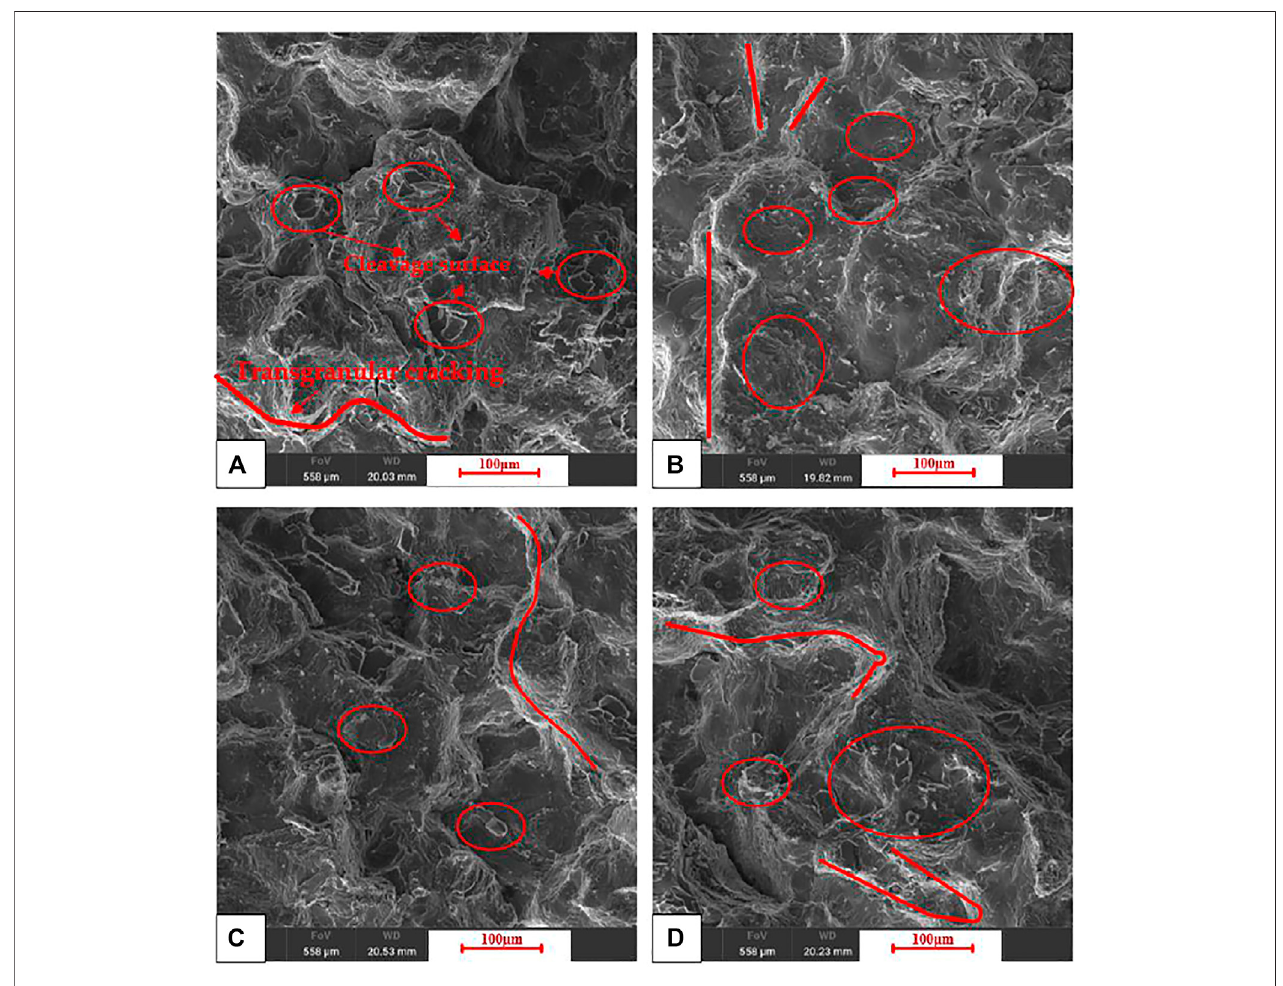
FIGURE 10 | SEM images of the tensile fracture surfaces in ingots cast under a total ultrasonic power of (A) 800 W, (B) 1,200 W, (C) 1,600 W, and (D) 1,800 W.